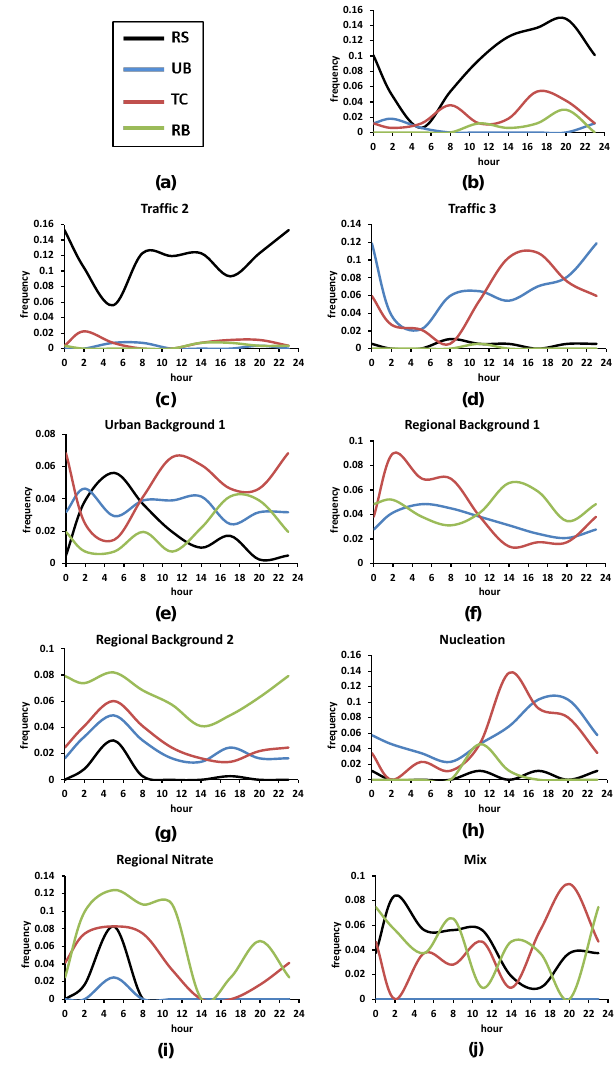
Fig. 2. Daily trends for each k -means cluster at the 4 sites (RS site , UB site , TC site and RB site ); (a) legend, (b) Traffic 1, (c) Traffic 2, (d) Traffic 3, (e) Urban Background 1, (f) Regional Background 1, (g) Regional Background 2, (h) Nucleation, (i) Regional Nitrate and (j) Mix.